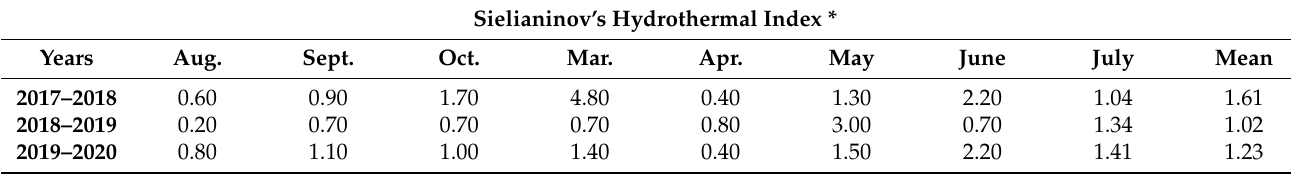
Table 3. Hydrothermal conditions during canola growing